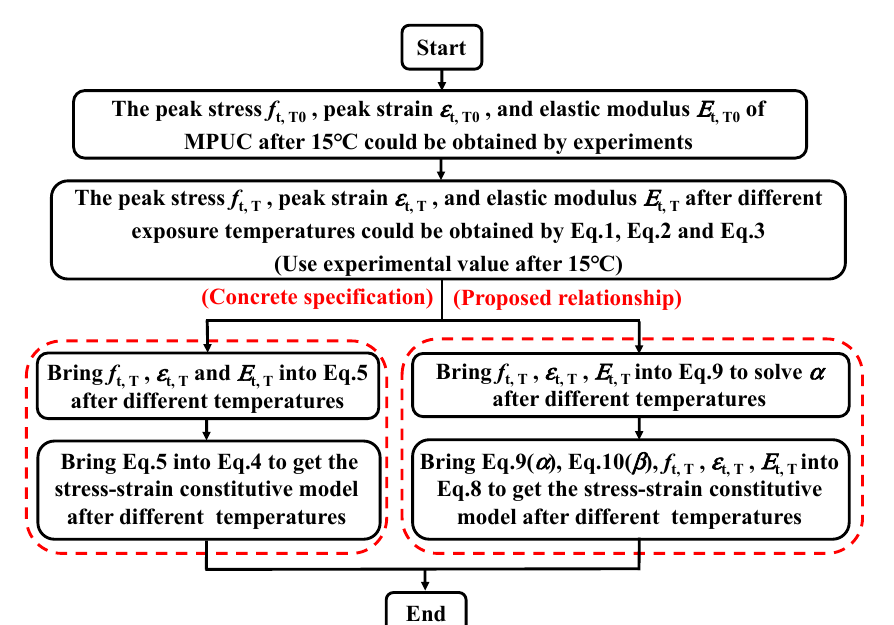
Figure 18. Comparison of algorithms for predicting stress-strain curves after different temperatures.